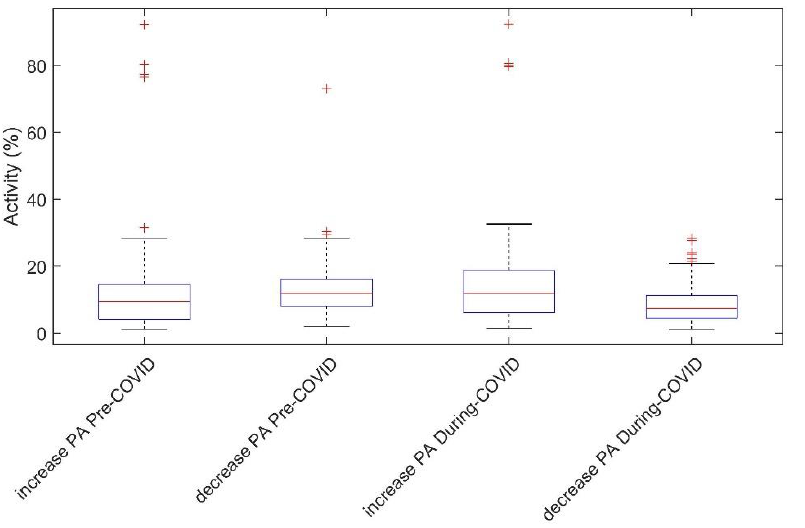
Figure 3. Box plot plots representing groups of individuals for whom an increase and decrease in activity were observed before and after COVID-19-related restrictions. Red crosses represent outliers.